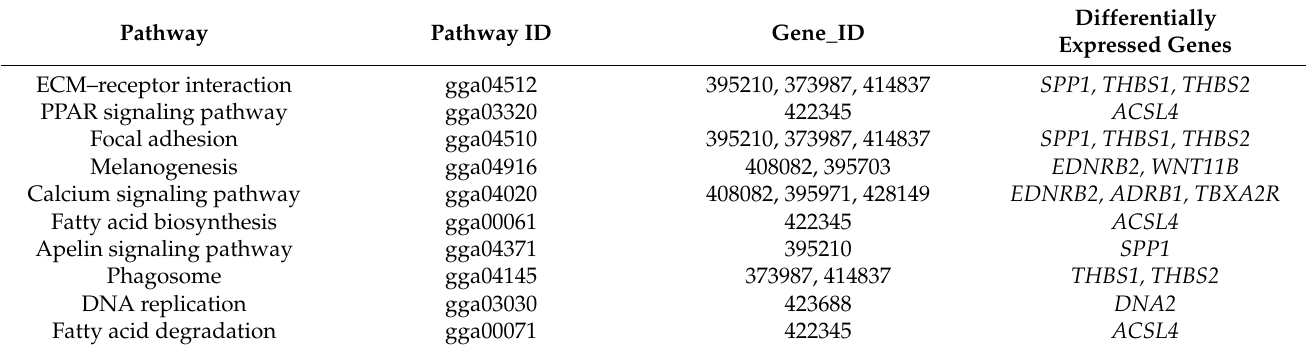
Table 1. KEGG enrichment analysis of 82 intersecting